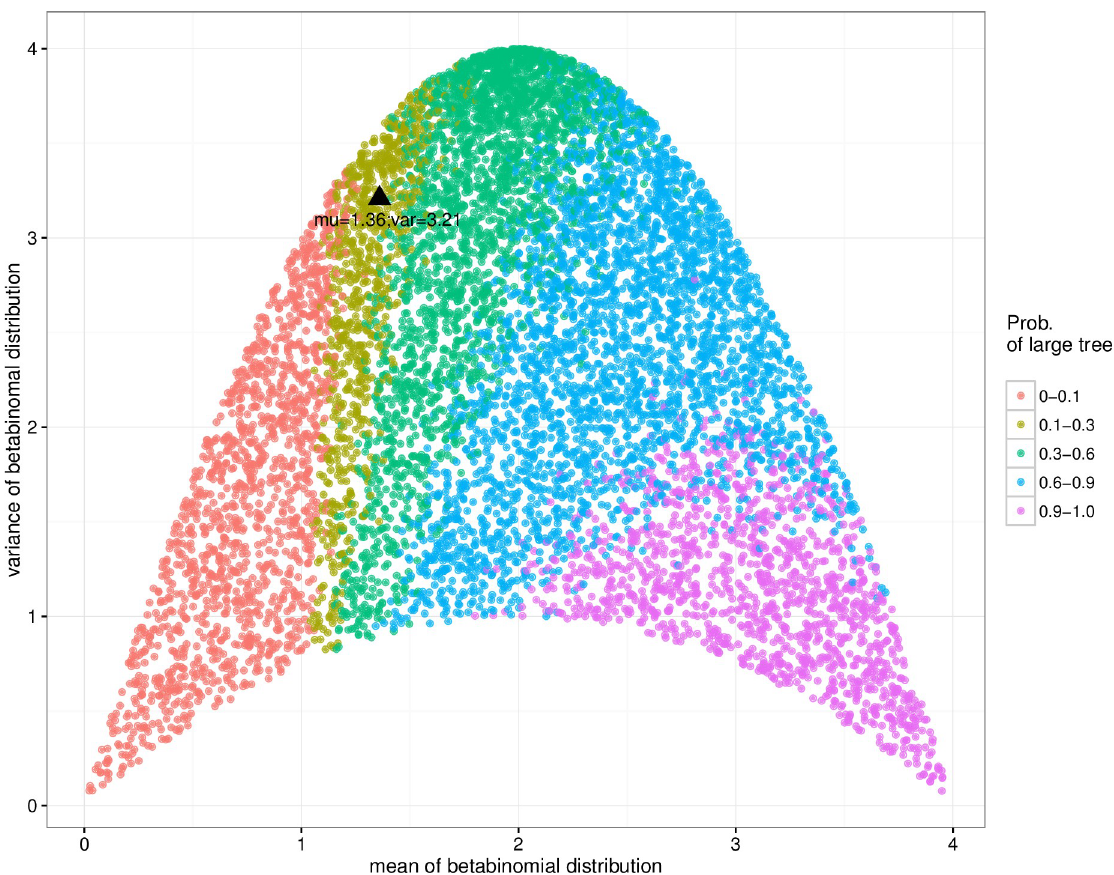
Fig 1. Relation between numbers of invitations and proportion of large recruitment trees. For 9000 randomly chosen combinations or μ and σ 2 for the beta-binomial distribution for number of invitations we ran 100 simulations (scenario S1). We then calculated the proportion of simulations runs that resulted in a large recruitment tree (N � 1000 recruitees) under the assumption of an acceptance probability of 1. The black triangle indicates the � x and s 2 of numbers of invitations sent out by participants in the data set collected in the